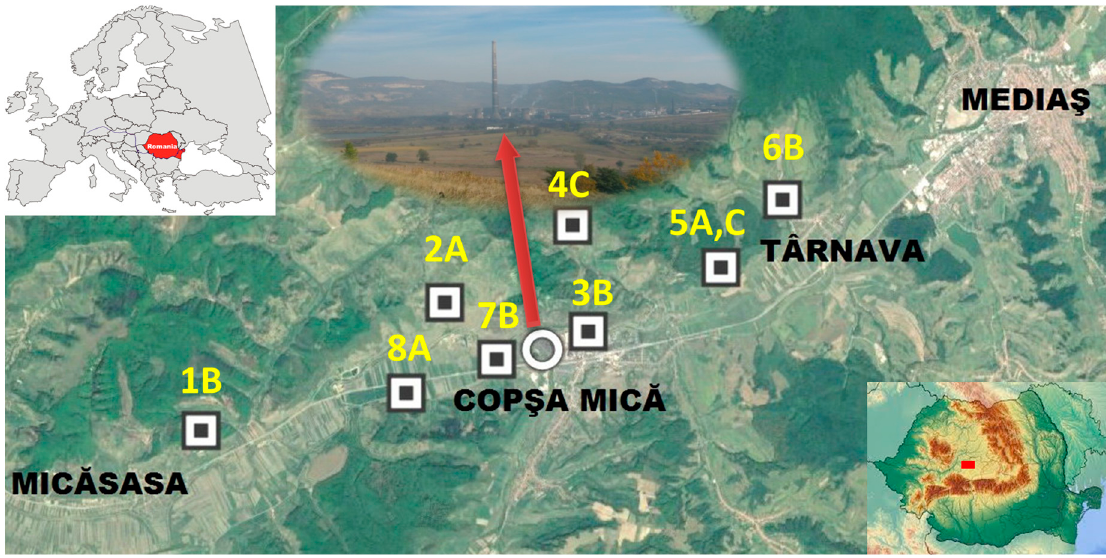
Figure 1. The sampling plots area: the circle marks the source of pollution; the squares mark the sample plots (numbered from 1 to 8 and identified with the type of site). plots (numbered from 1 to 8 and identified with the type of Table 2. Classification of sampled sites according to the location in relation to the source of pollution.